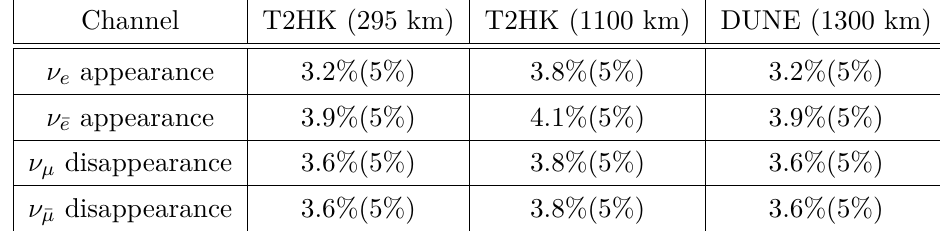
Table 3 . The signal (background) normalization uncertainties of the experiments for the various channels for T2HK, T2HKK and DUNE.